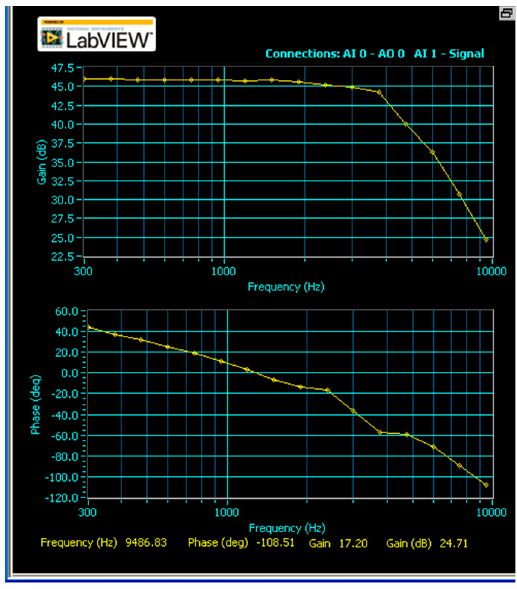
Figure 15. Empirical frequency response of the APD.